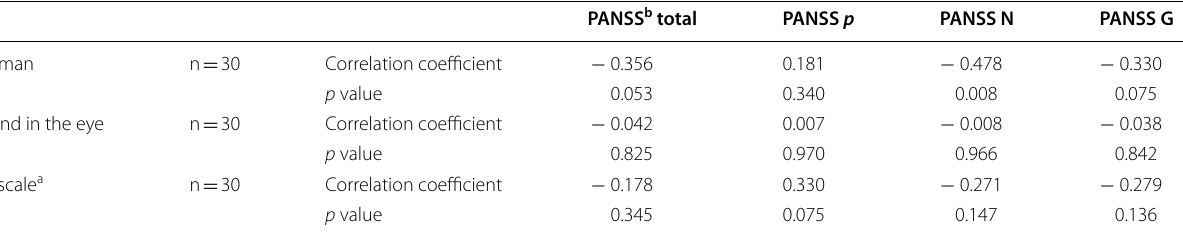
Table 4 Correlation between social cognition (using RMET, Ekman and EI scale) and symptoms severity using the PANSS in patients with schizophrenia